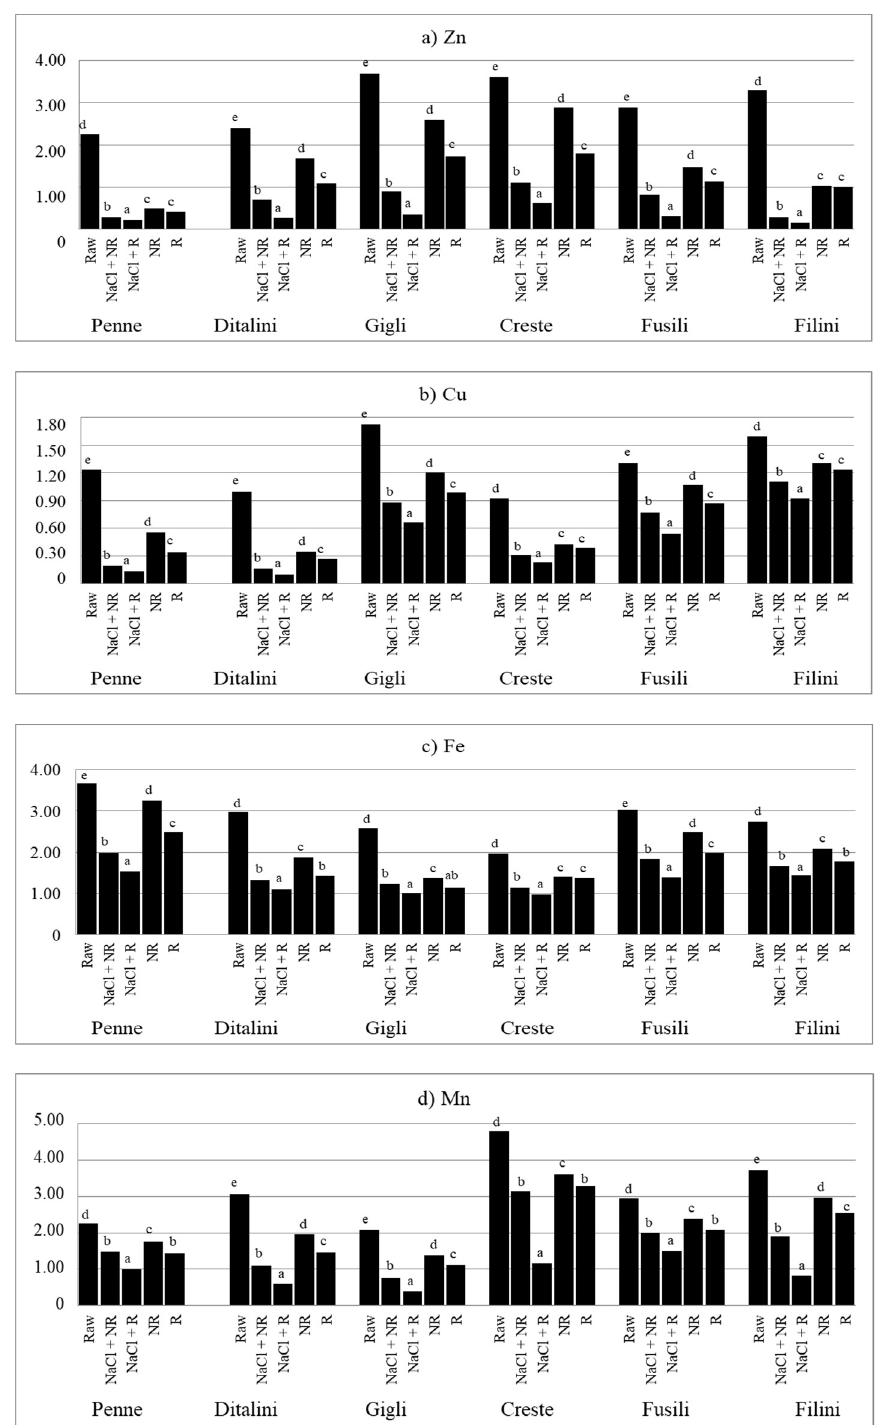
Figure 2. The content of: ( a ) Zn; ( b ) Cu; ( c ) Fe; ( d ) Mn in pasta, mg kg − 1 fresh weight. Raw—raw pasta; NaCl + NR—cooked with salt and not rinsed; NaCl + R—cooked with salt and rinsed; NR— cooked without salt and not rinsed; R—cooked without salt and rinsed; a,b,c,d,e —values with different superscripts differ at p < 0.05 by Duncan’s